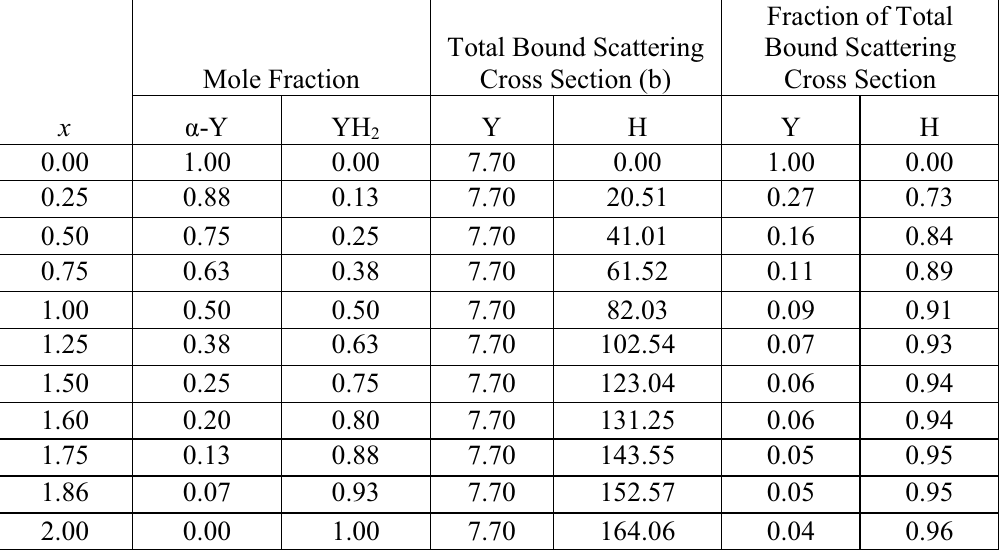
Table II. Comparison of Hydrogen and Yttrium Fractions in the Total Bound Scattering Cross Sections of Various Bulk YH x Compositions (Unit Y Atom Basis) Fraction of Total Bound Scattering Total Bound Scattering Mole Fraction Cross Cross Section (b) x